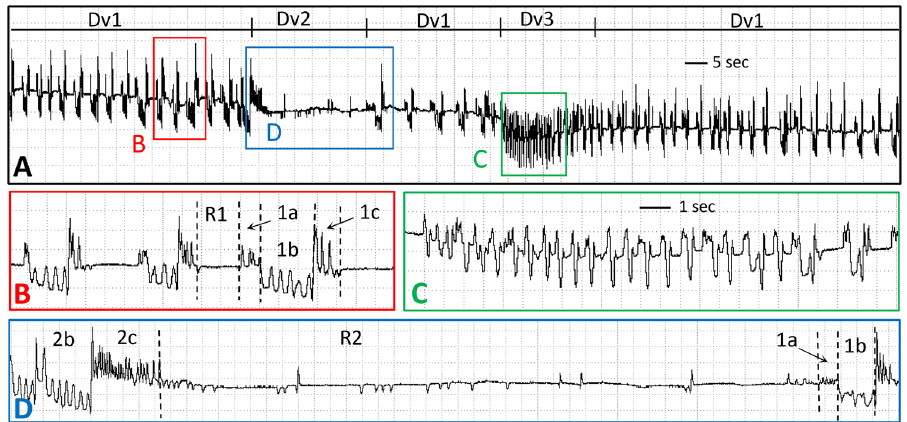
Figure 1. EPG waveforms for D. variabilis feeding approx. 36 h after attachment to calf. ( A) Compressed view of three Dv1 events and intervening Dv2 and Dv3 events. Labelled boxes contain waveform segments that are expanded in parts with the same letter label. Windaq gain 64×. ( B) Two and a half episodes of Dv1 showing all four types, Dv1a, Dv1b, Dv1c and DvR1, but with Dv removed from each label to save space. ( C) One event of Dv3. ( D) One event of Dv2, plus the start of the next Dv1 event. See narrative for further descriptions of waveform names. Scale bar in part C and Windaq gain of 128 × same for parts B – D.